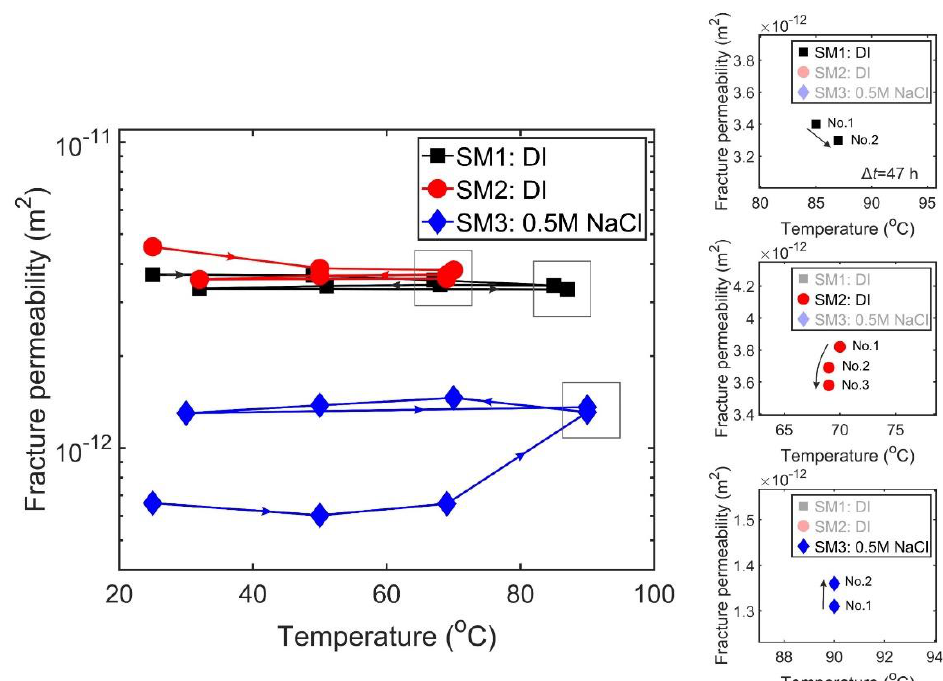
Figure 4. Fracture permeability variations during the temperature cycles between room temperature and up to 90 °C (SM1 and SM3) and 70 °C (SM2) (left panel). The arrows indicate the heating and cooling sequences. All tests started at approximately 25 °C. Details of permeability variations at the respective target temperatures (grey boxes) after first and second heating are shown in the three panels on the right. Sample SM2 was measured twice (No.1 and No.2) at 70 °C after first heating within a time interval of 15 h, indicating a time-dependent permeability reduction at constant temperature. After second heating of this sample, the respective permeability value is therefore labelled No. 3. Error bars are in the range of ±2 × 10 −14 m 2 and hence not visible on the logarithmic y-axis.